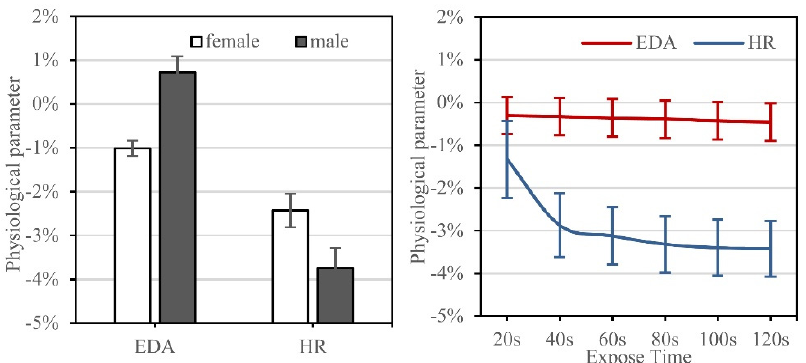
Figure 10. Effects of gender and exposure time on physiological responses to traffic sounds. The vertical bars represent 95% confidence intervals.